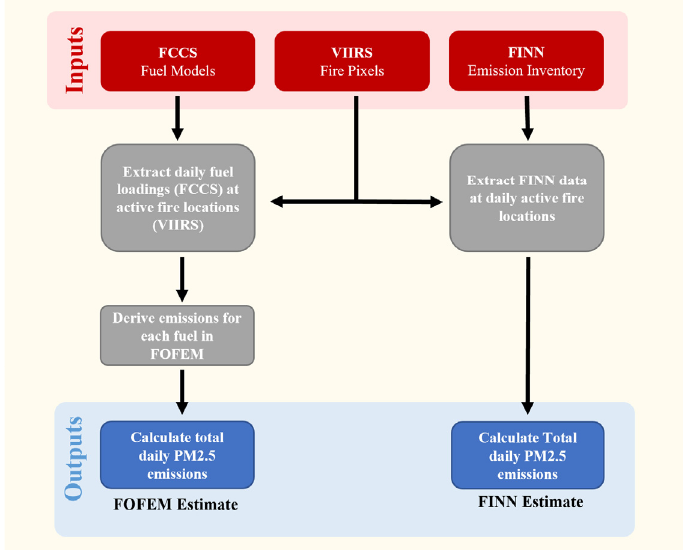
Figure 2. Flowchart of the emission estimation algorithm.